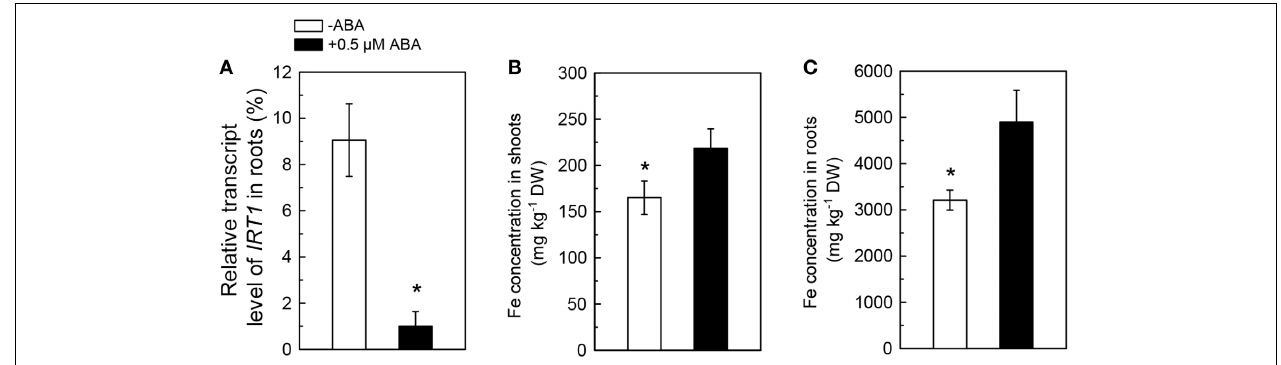
FIGURE 3 | Effects of ABA on IRT1 expression and Fe concentration in Col-0 plants. Plants were grown in 10 µ M Cd-added nutrient solution containing 0 or 0.5 µ M ABA. The Fe level in the nutrient solution was 25 µ M. The expression of IRT1 and Fe concentration were analyzed after 3 and 7 days of treatments,